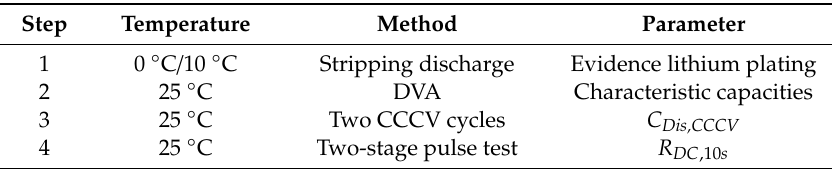
Table 1. Check-up test comprises four sequential steps. Di ff erent methods are used in the sequential steps to determine di ff erent parameters of the cell’s aging condition.